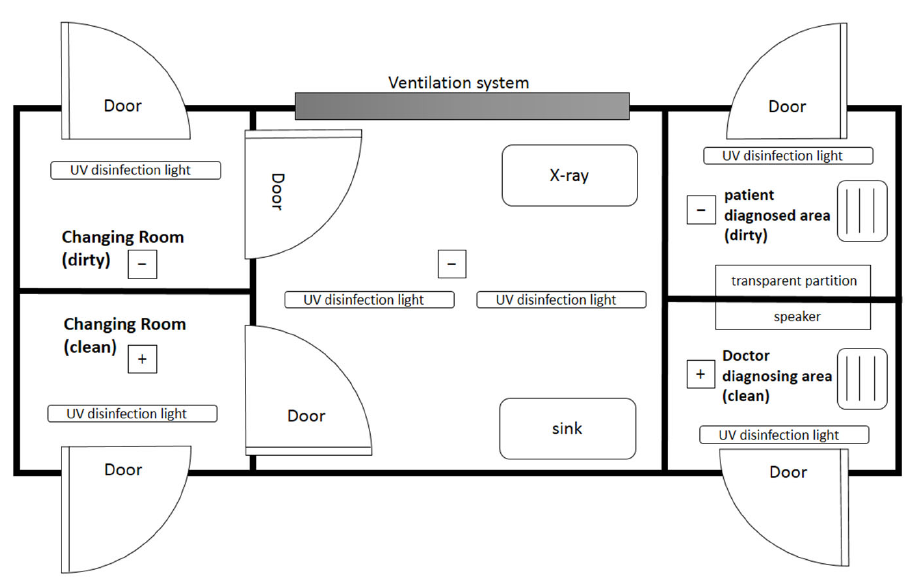
Figure 5. Layout of the fever clinic.